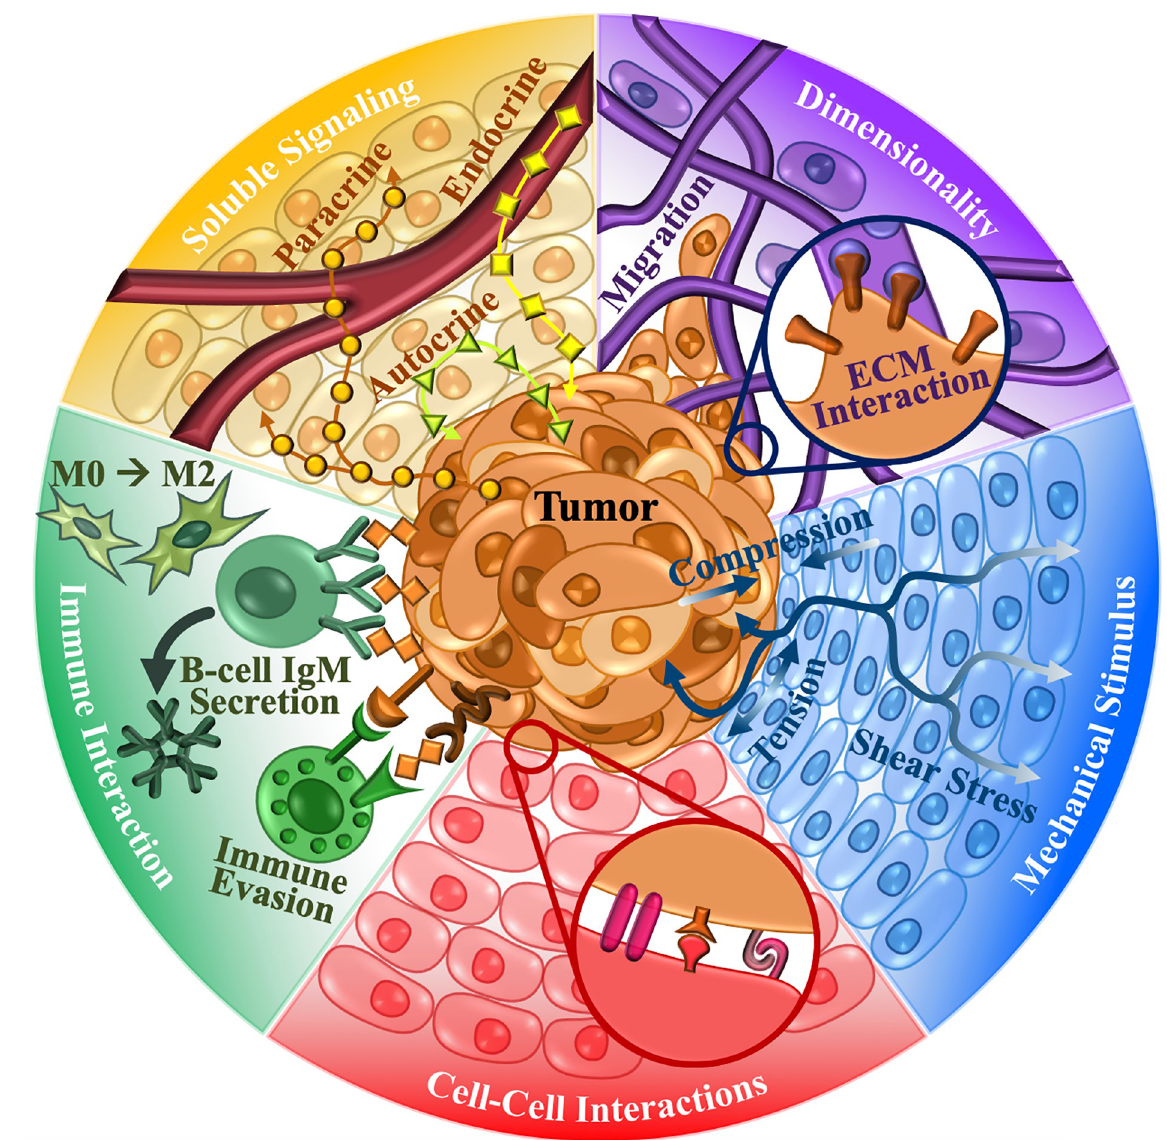
Fig 1. Components of the ‘Cancer-Organ’ model. To develop an accurate multi-dimensional understanding of the structure, organization, and complex relationships in cancers, we need to consider the following factors. Heterogeneous cancer cells reside in a complex tumor microenvironment, which consists of mechanical stimuli, non-malignant cell-cancer cell interactions, soluble signals, and extracellular matrix (ECM). The dimensionality of cell culture influences cancer cell motility and cellular interaction with the surrounding cells and ECM. Mechanical stimuli including shear, compressive, tensile, and viscoelastic forces, dynamically influence cancer cells as the tumor grows. Similarly, cellular interactions through direct contact with surrounding non-malignant cells and soluble signals alter communication and downstream signaling. Interactions between immune cells and cancerous cells are highly complex and can lead to immune evasion and support of tumor progression. All of these characteristics play an integral role in tumor progression and are critical to forming a complete picture of the ‘cancer-organ’